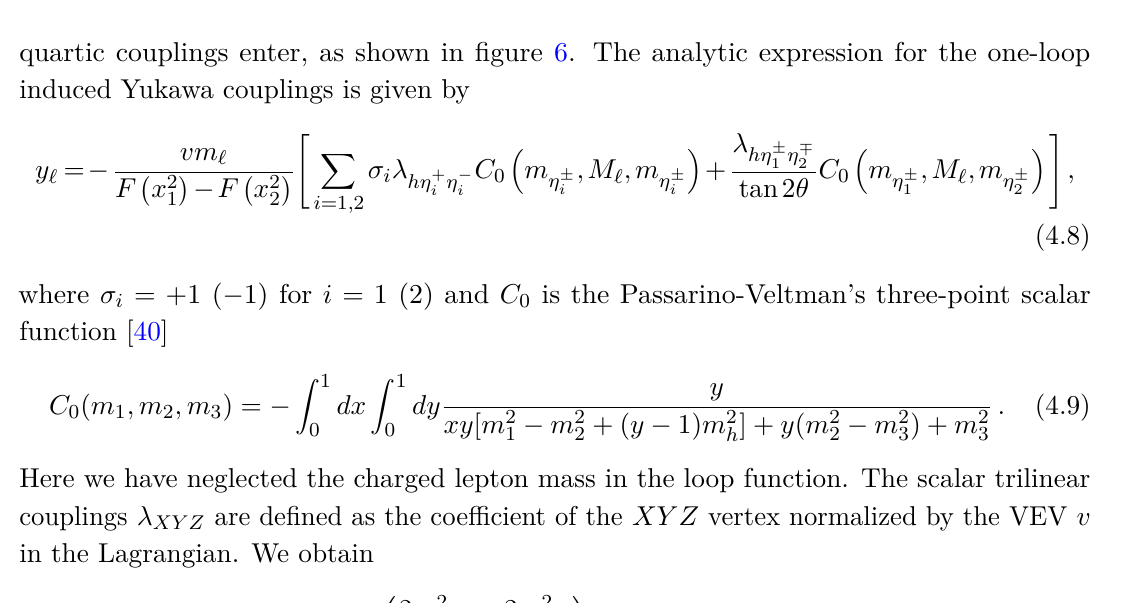
Figure 6 . One-loop induced Yukawa couplings for charged